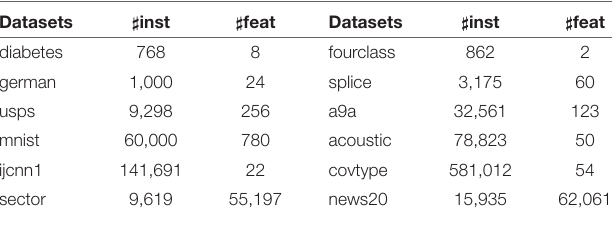
TABLE 2 | Basic information about the benchmark datasets used in the experiments. Datasets